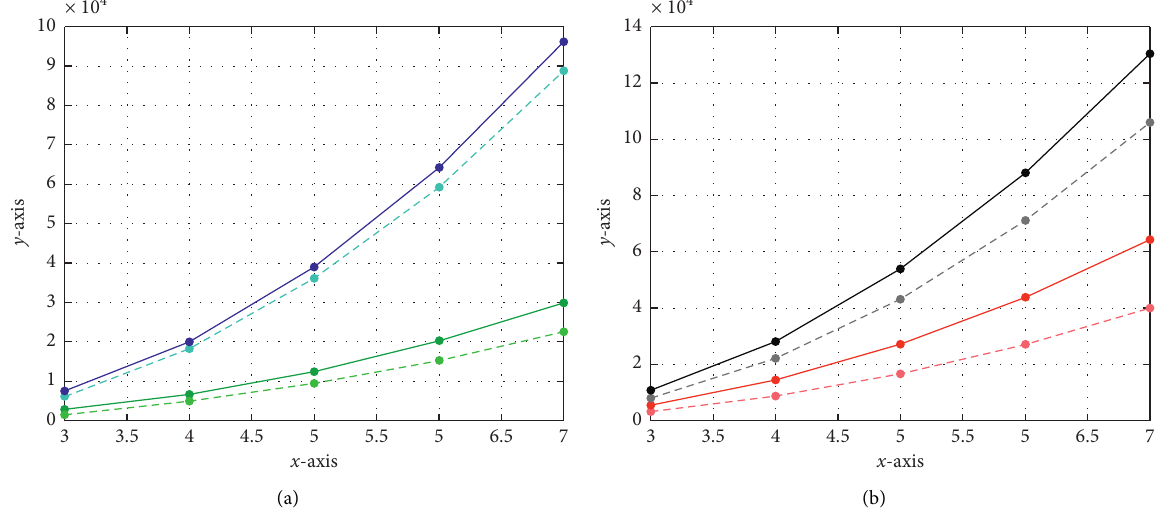
Figure 9: Compression between F -index of F dotted line and dark green solid line, and F ( P n respectively. (b) F ( P n by grey dotted line and black solid line, respectively.